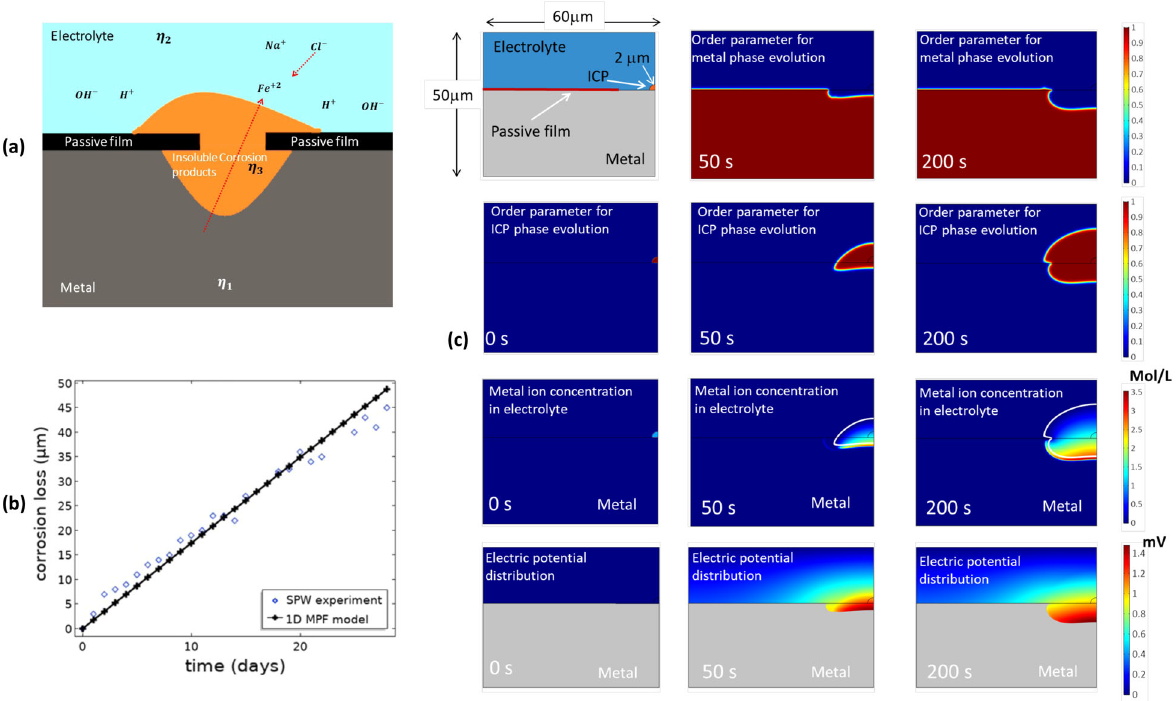
Fig. 2 Pitting corrosion with passivation kinetics. a Schematics of a PF model with passivation kinetics for iron (Fe) corrosion in a NaCl solution. b Plots of corrosion loss versus time for the MPF simulations and experimental results. c Evolution of metal, ICP phase, metal ion concentration and electric potential distribution as a function of time 80 . All panels are reproduced with permission from ref. 80 , published by nature springer in